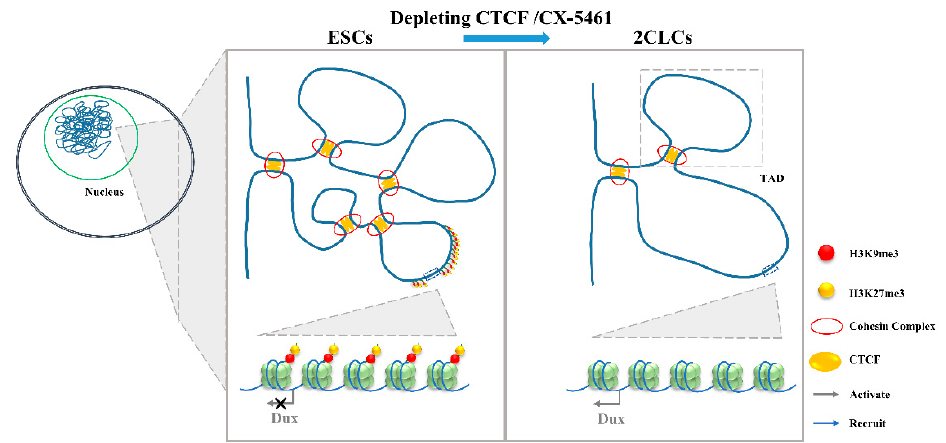
Figure 4. The 3D genome conformation determines the expression of Dux. The disruption of chromatin organization by the depletion of CTCF or addition with CX-5461 will lead to the lower TAD strength and TAD insulation and, finally, upregulate Dux expression. ESCs, embryonic stem cells; 2CLCs, 2-cell-like cells; CTCF, CCCTC-binding factor; TAD, topologically associating domains.